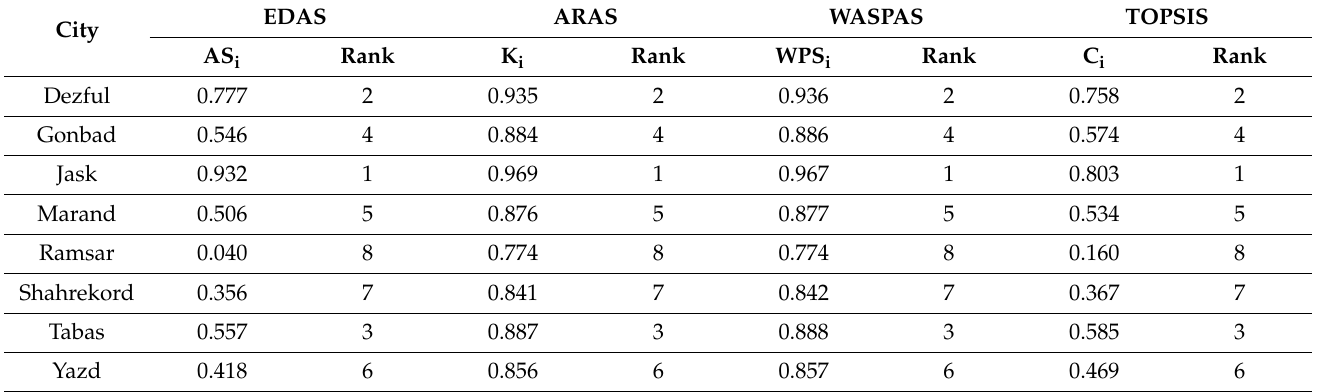
Table 14. Results of ranking of cities on a 60 ◦ slope.